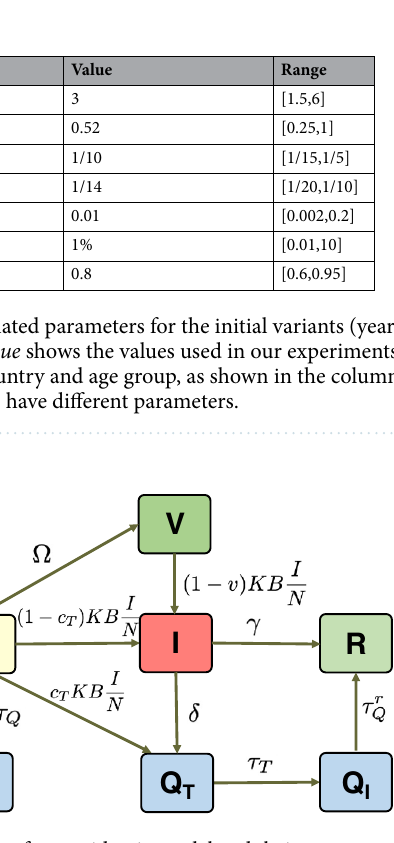
Figure 2. Transitions of our epidemic model and their